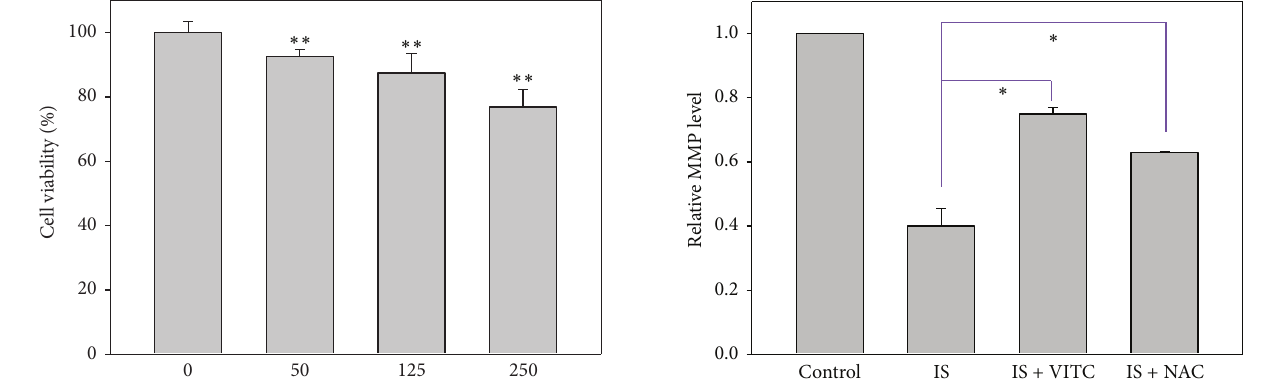
Figure3:RoleofantioxidantsinIS-inducedmitochondrialdepolar- ization in HUVECs. Quantification analysis of relative MMP mean intensity (% of control) of Rhodamine 123. Cells were treated with IS 125 𝜇 g/mL alone as the positive control, cotreated with IS 125 𝜇 g/mL and vitamin C 200 𝜇 M or NAC 10mM for 48h. Cells without IS treatment were regarded as the negative control. Data, mean ± SD ( 𝑛 = 2 ). ∗ 𝑃 < 0.05 compared to the